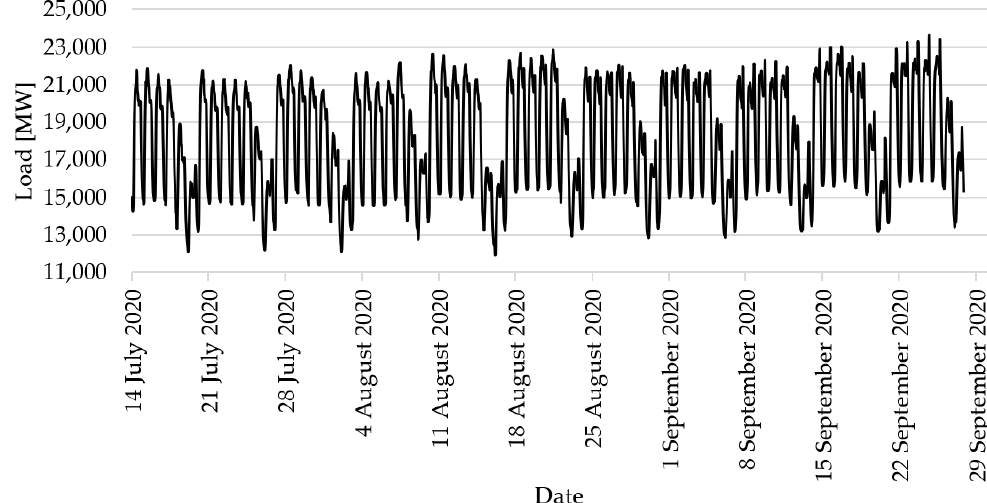
Figure 7. Reference (clean) load time series.